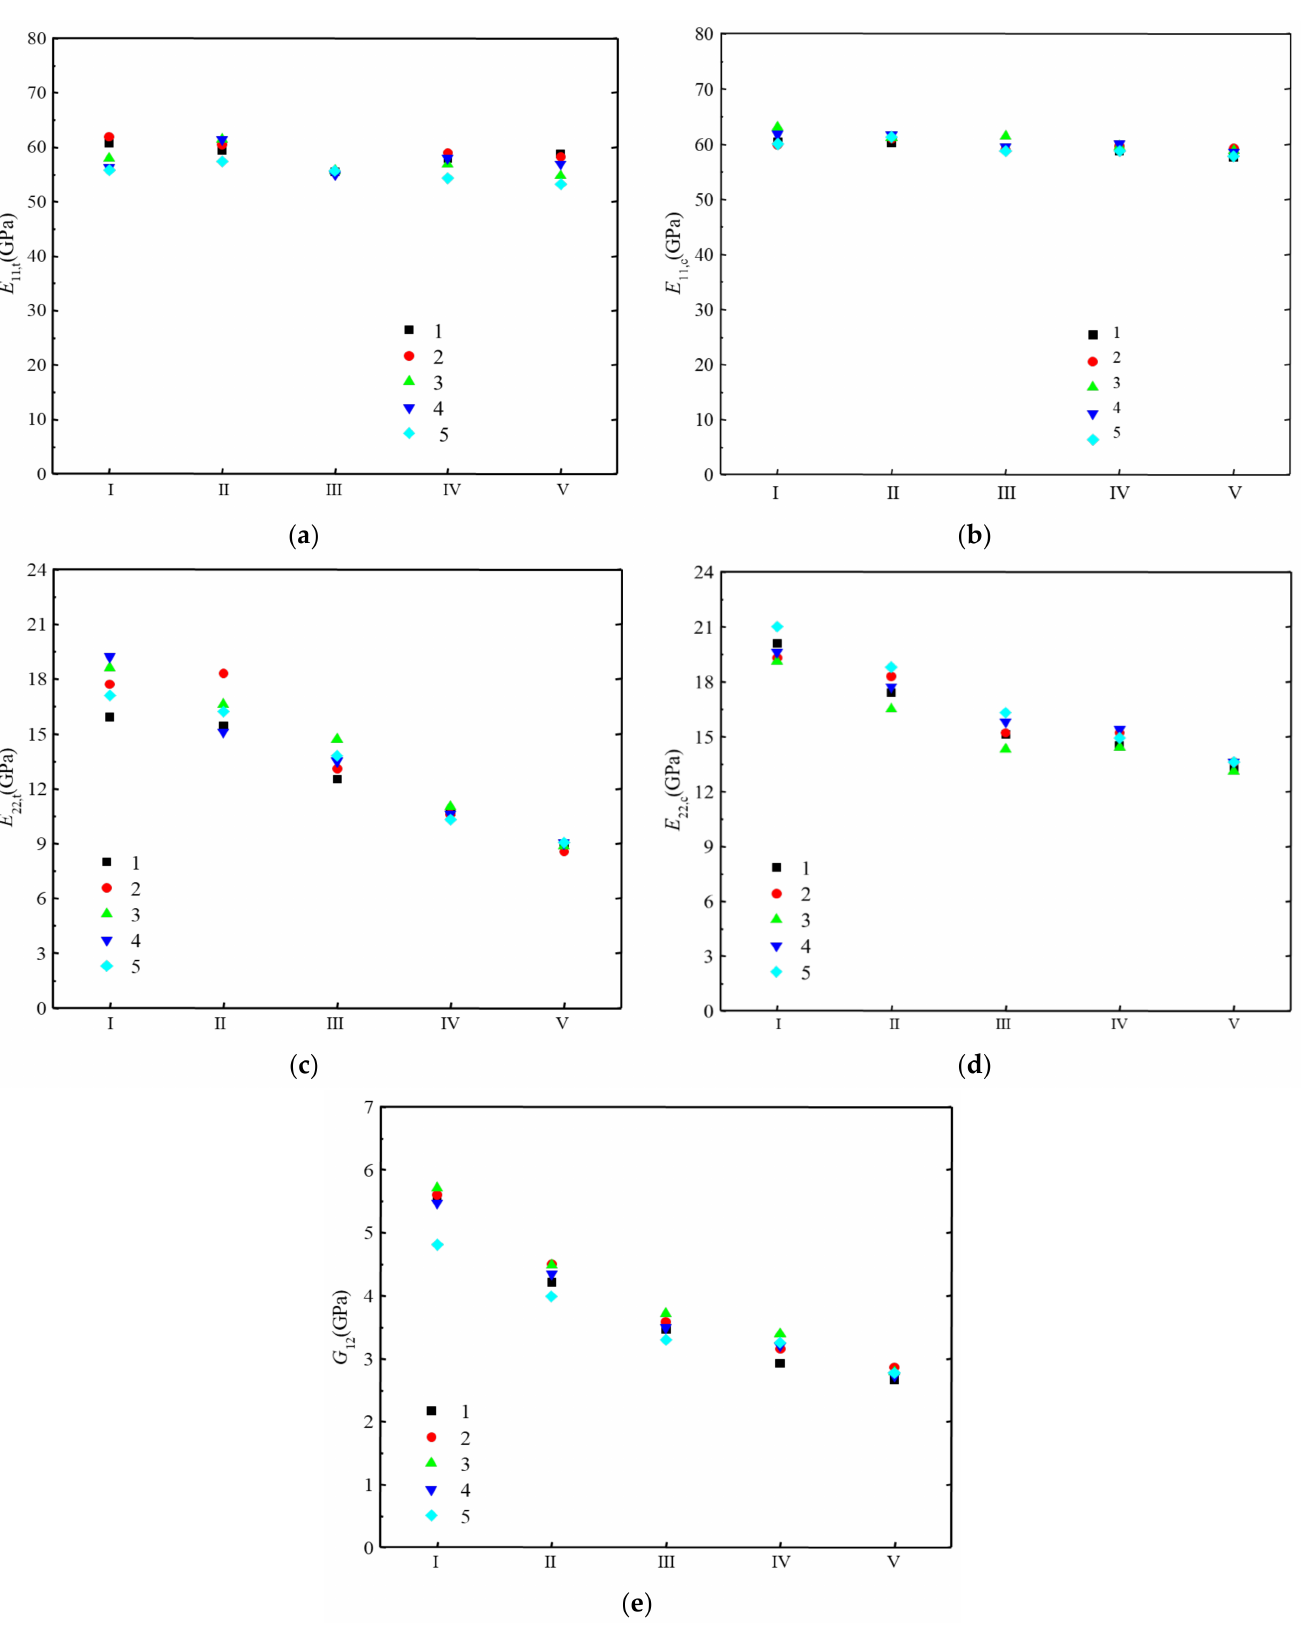
Figure 1. Test results of stiffness performance of H-GFRPs. ( a ) E 11,t , ( b ) E 11,c, ( c ) E 22,t , ( d ) E 22,c, ( e ) G 12